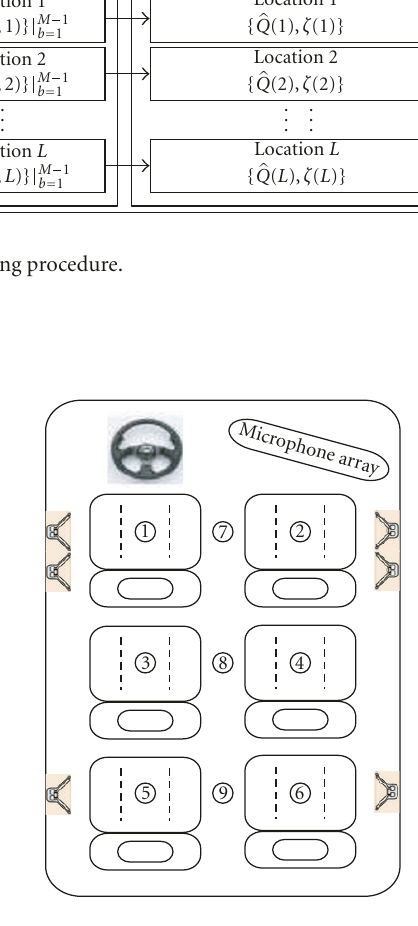
Figure 4: Locations number of the